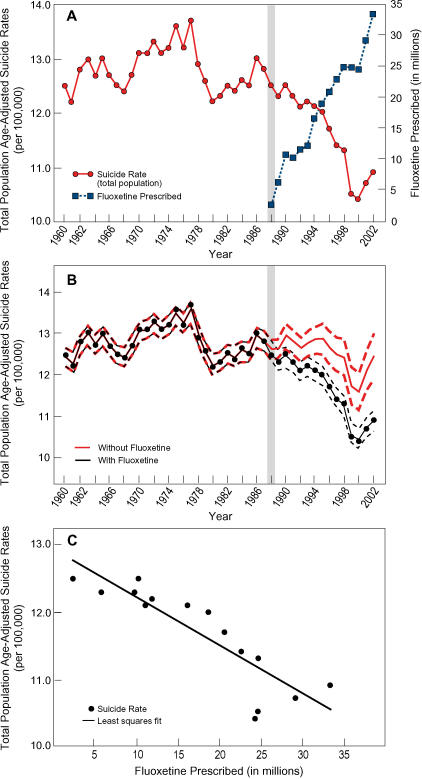
Age-Adjusted Suicide Rates at the Population Level(A) Age-adjusted suicide rates (per 100,000) for the total population from 1960 to 2002 and fluoxetine prescribed numbers (in millions) from 1988 to 2002(B) Age-adjusted suicide rate predictions for the total population. The solid lines trace out the posterior median model predictions and the dashed lines depict the 95% Bayesian credible intervals. The top red line depicts the predicted suicide rates without fluoxetine and the bottom black line represents the actual rates with fluoxetine.(C) This figure demonstrates the linear relationship between suicide rates and fluoxetine prescription numbers.